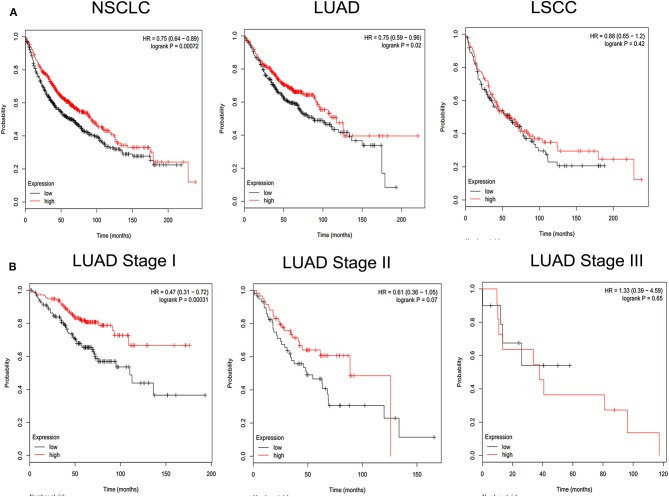
KM survival curve and log-rank test for patients with Cbl-b high or low expression in different pathological types of NSCLC and LUAD at Stage I, Stage II, Stage III. Online Kaplan Meier plotter Database was used to analysis. (A) KM survival curve of Cbl-b in non-small cell lung cancer (NSCLC), lung adenocarcinoma (LUAD), lung squamous carcinoma (LUSC). (B) KM survival curve of Cbl-b in different pathological stage in LUAD.